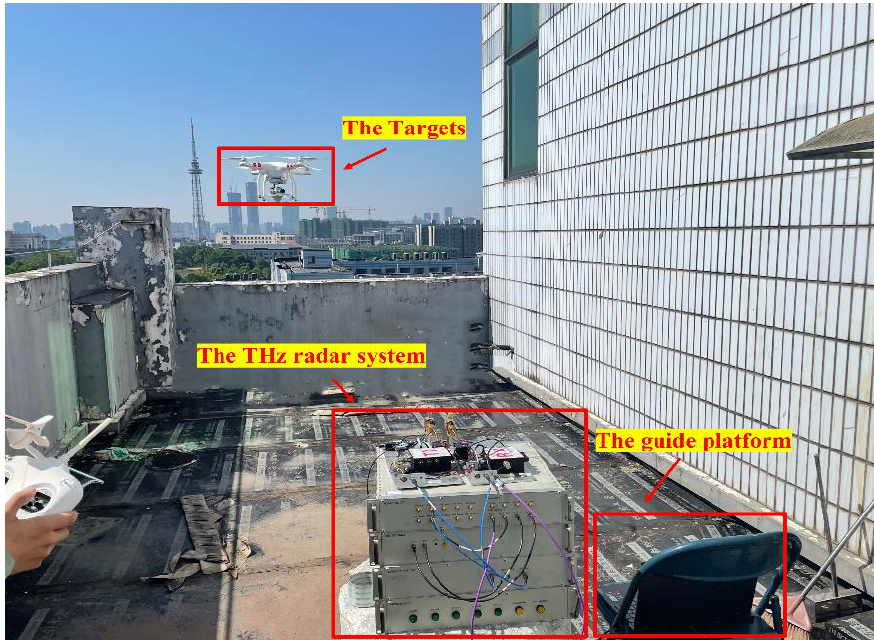
Figure 4. The experiment scene.